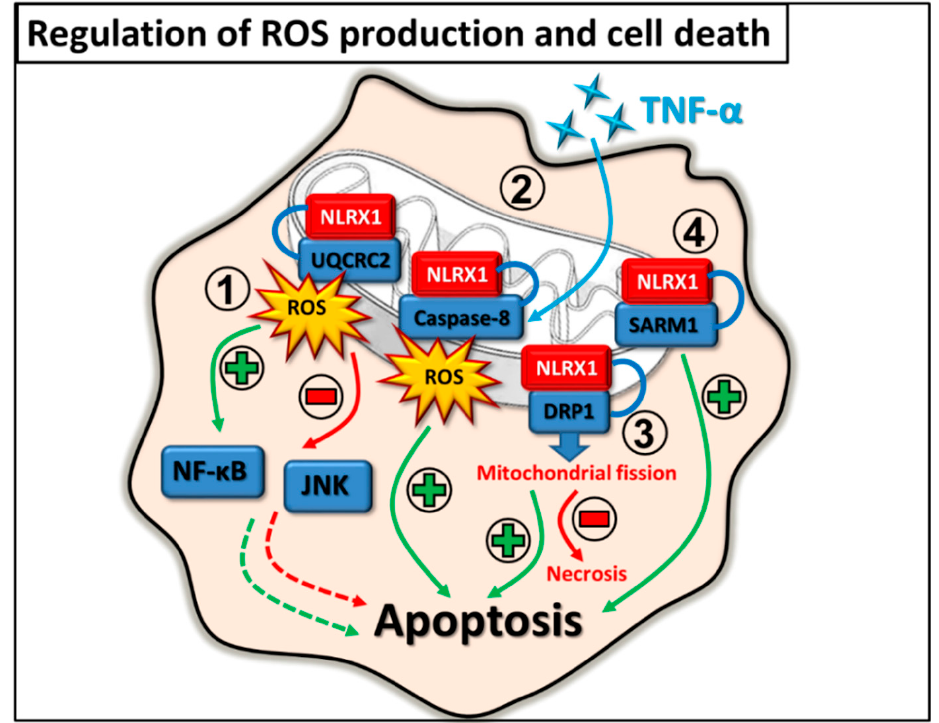
Figure 5. Regulation of ROS production and cell death by NLRX1. 1. NLRX1 interacts with UQCRC2 and can either induce or inhibit mtROS production in a cell type dependent manner. Through regulating mtROS production, NLRX1 might have either a positive or negative effect on NF- κ B and JNK inflammatory pathways and on the induction of apoptosis. 2. NLRX1 positively regulates the TNF- α -induced caspase-8 dependent apoptosis via the interaction with the mitochondrial localized caspase-8. 3. NLRX1 binds to DRP1, and thus promotes mitochondrial fission, inhibits necrosis while supporting apoptosis. 4. NLRX1 interacts with SARM1 and promotes SARM1-dependent